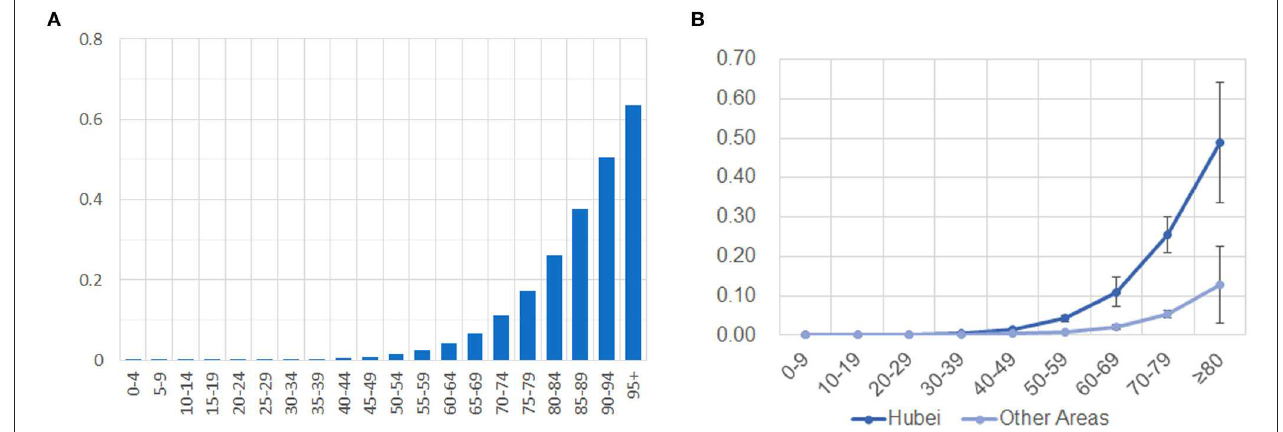
FIGURE 3 | Different mortality risks in different age groups and different parts of China. (A) Mortality risks of all fatal cases dramatically increases in older age groups. (B) Mortality risks are significantly different in Hubei and other areas of China. The risk is present on the y-axis, while the ages of grouped cases are shown on the